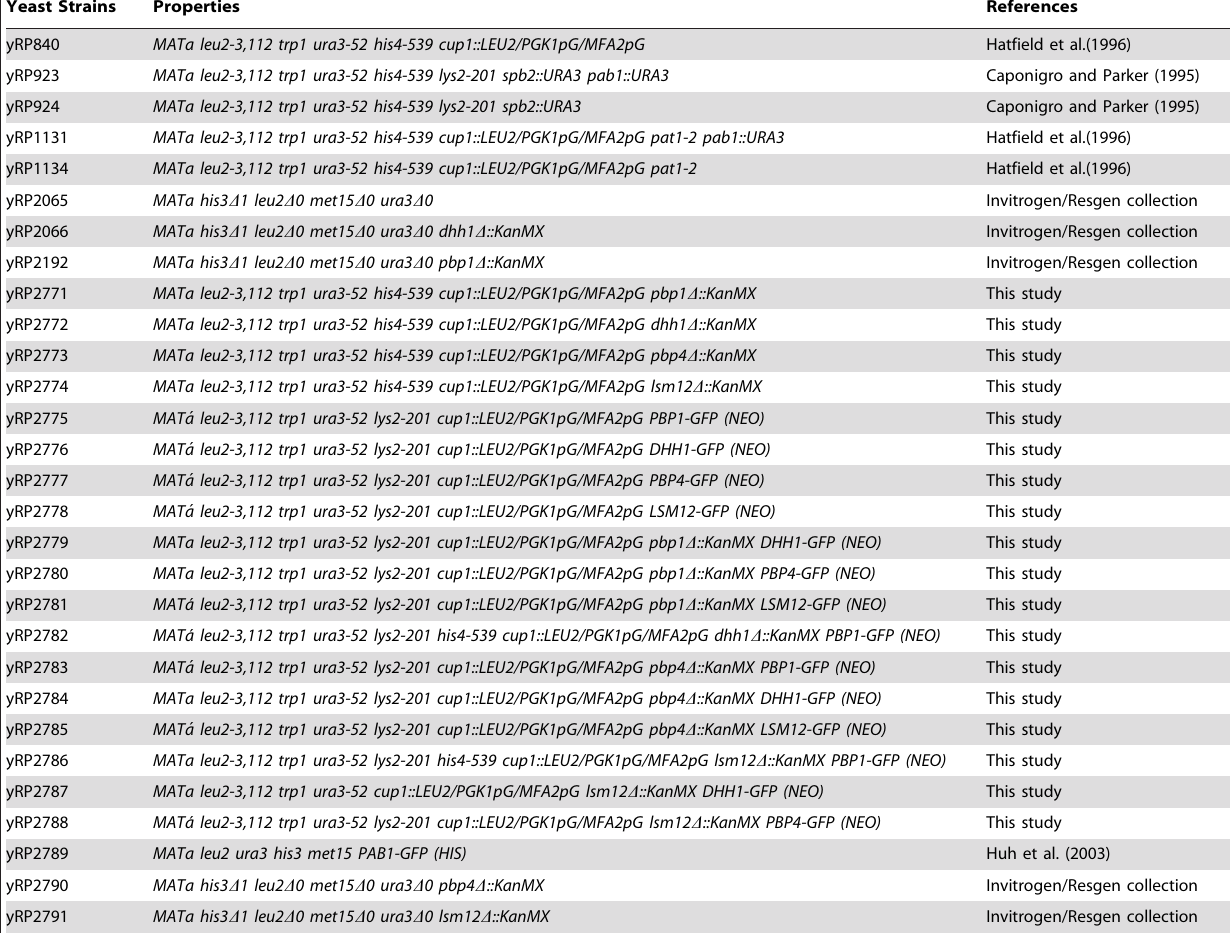
Table 1. Yeast Strains used in this